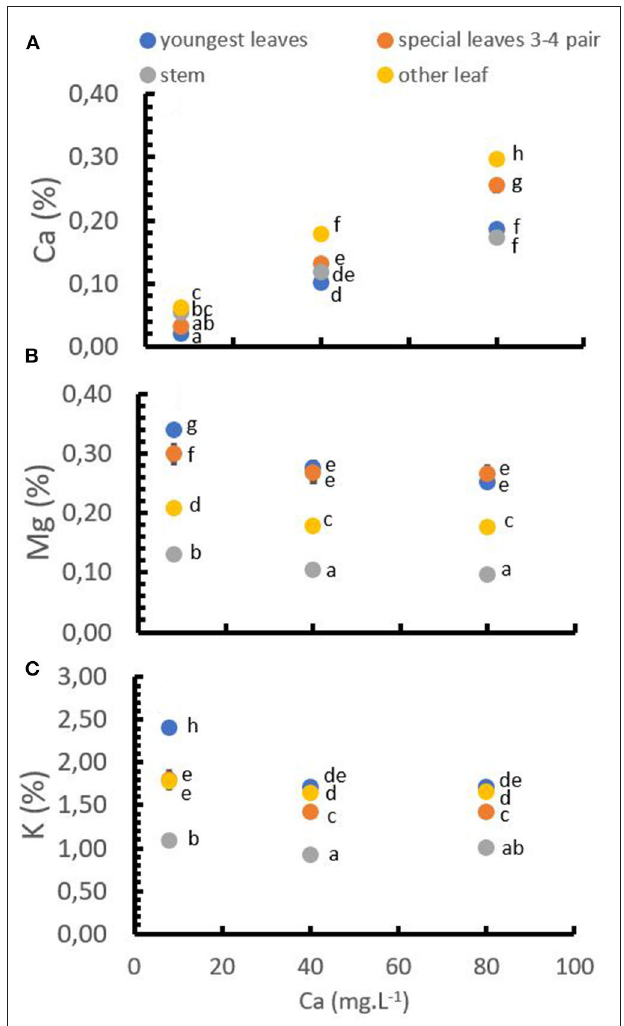
FIGURE 5 | Cation distribution in different parts of the plant at different Ca + 2 rates. Ca + 2 in tissues (A) , Mg + 2 in tissues (B) , and K + in tissues (C) . Points represent the mean values for each of the replicates ± standard error. Different letters represent statistically significant differences among the treatments ( P < 0.05, LSD fisher).